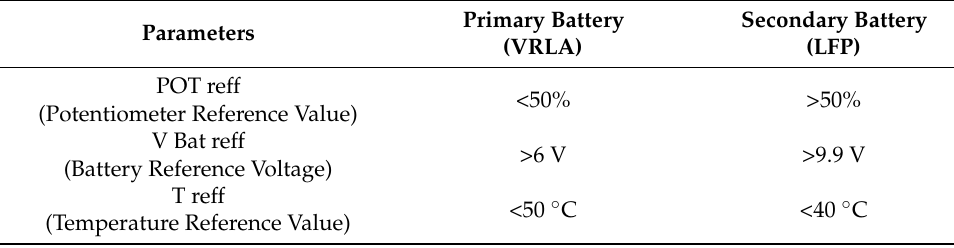
Table 2. Critical limits of Dual Battery VRLA and